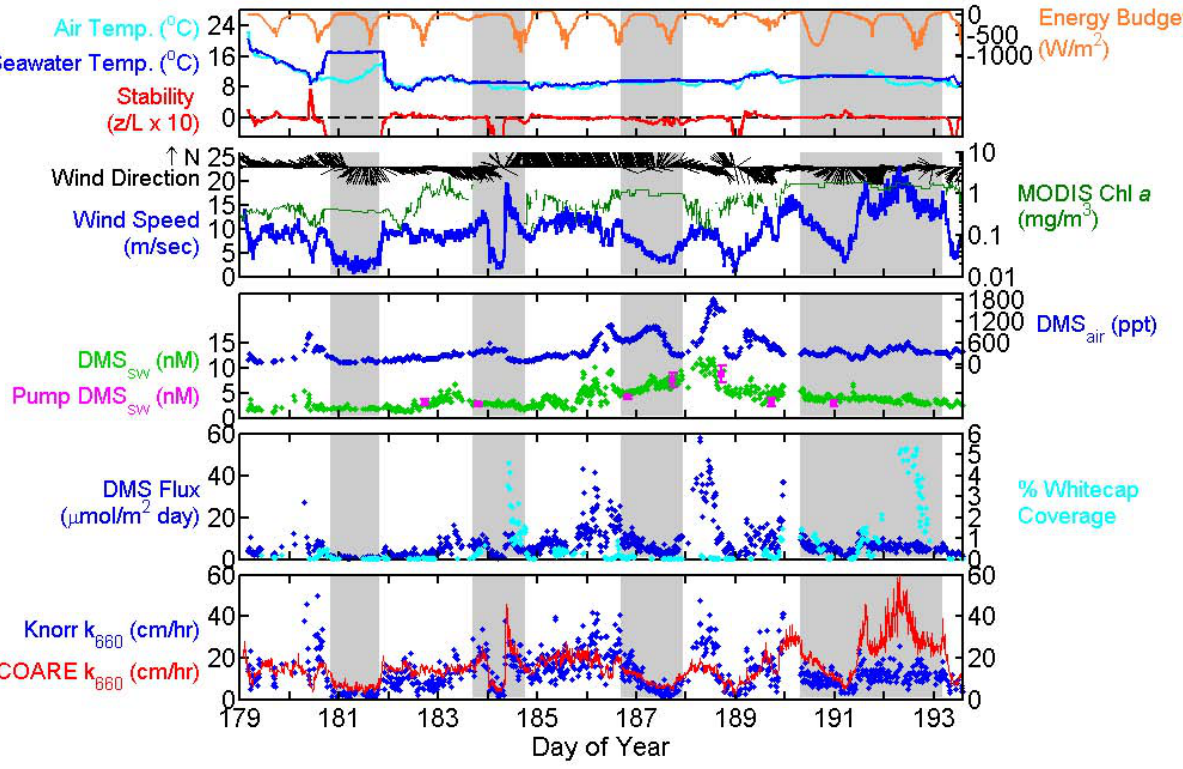
Fig. 2. Time series data from the Knorr_11 cruise. Dashed black line on top panel indicates neutral atmospheric stability ( z/L = 0). Sub- mersible pump DMS sw error bars are ± 1 σ